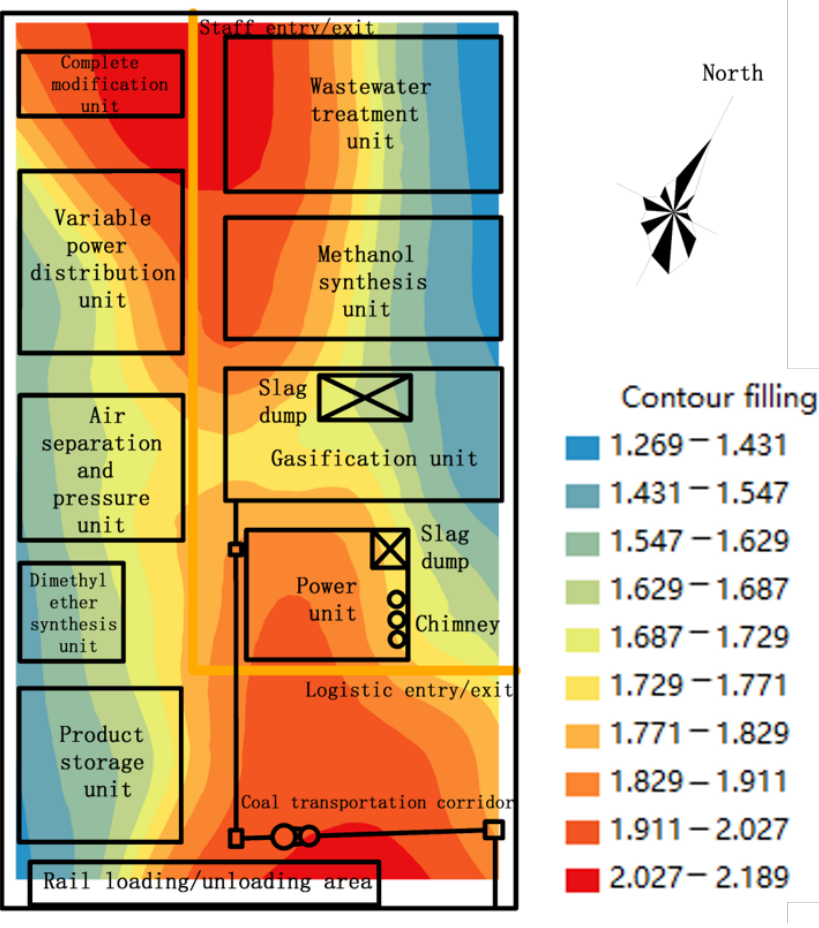
Figure 3. Cd total carcinogenic risk.